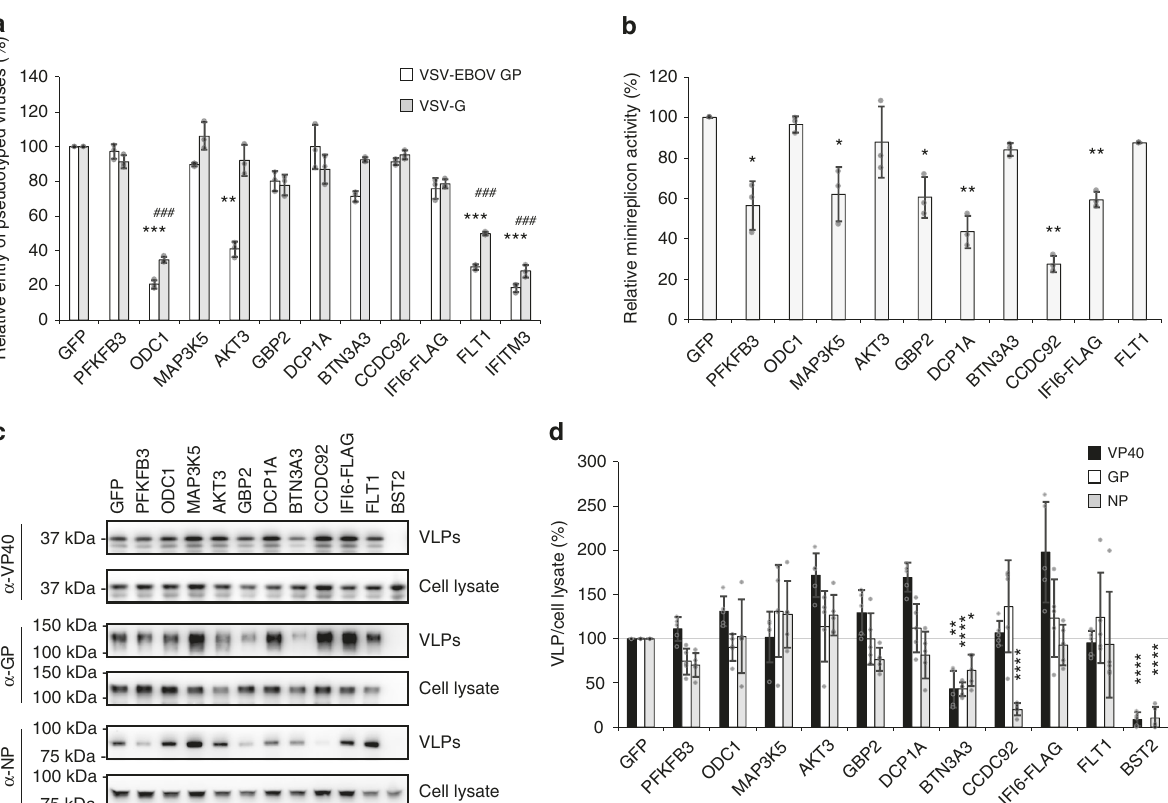
Fig. 3 Effect of selected ISGs on EBOV cell entry, transcription/replication, and virion formation/budding. a Relative luciferase activity in HEK-293T cells after transfection for 24 h with each of the selected ISGs and infection with VSV-EBOV GP virus (black bars) or VSV-G (gray bars) at an MOI of 0.5. IFITM3 served as a positive control for inhibition of virus entry. Data are presented as means± SD, and are representative of three independent experiments. (*) indicates a statistically signi fi cant difference ( p -values of two-tailed Student ’ s t -tests; ** p < 0.01, *** p < 0.001) for VSV-EBOV GP compared with the negative control; (#) indicates a statistically signi fi cant difference ( p -values of two-tailed Student ’ s t -tests; ### p < 0.001) for VSV-G virus compared with the negative control. b Relative luciferase activity in HEK-293T VP30/L cells after transfection for 48 h with vectors encoding the remaining minireplicon components, each of the 10 selected ISGs, and an internal Renilla luciferase control vector. Data are presented as means ± SD, and are representative of three independent experiments. (*) indicates a statistically signi fi cant difference ( p -values of two-tailed Student ’ s t -tests; * p < 0.05, ** p < 0.01) from the control. c , d Representative western blot showing expression of EBOV VP40, GP, and NP in VLPs and cell lysate from transfected HEK- 293T cells ( c ). The ISG BST2/tetherin, a known inhibitor of VP40-driven VLP formation, was overexpressed with VP40 alone as a positive control. Data are representative of fi ve independent experiments. Quanti fi cation analysis of the viral proteins (VP40, GP, and NP) in VLPs following ISG overexpression compared with the GFP control was performed using ImageJ software ( d ). The ratio of the band intensity in the VLP to that in the cell lysate is indicated as a percentage. Data are presented as the mean ± SD ( n = 5). (*) indicates a statistically signi fi cant difference ( p -values of two-tailed Student ’ s t -tests; * p